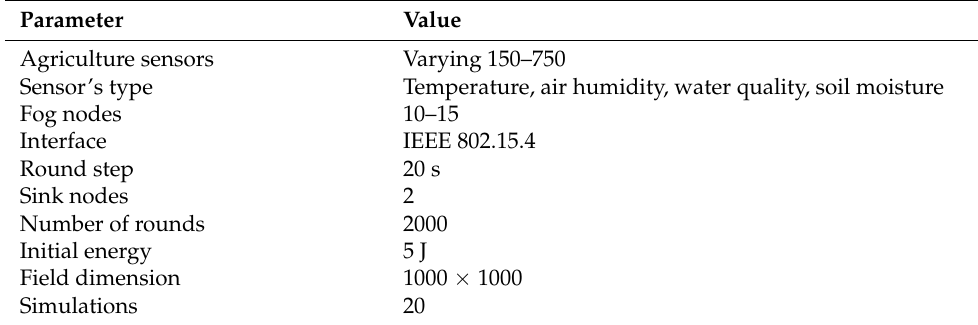
Table 2. Simulation